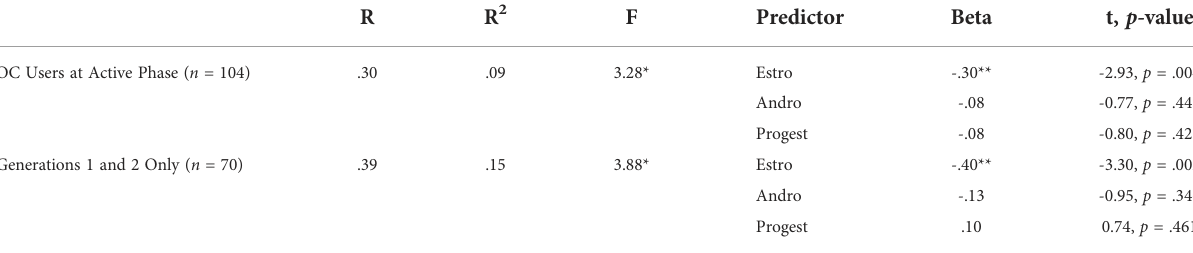
TABLE 3 Results of the multiple regression